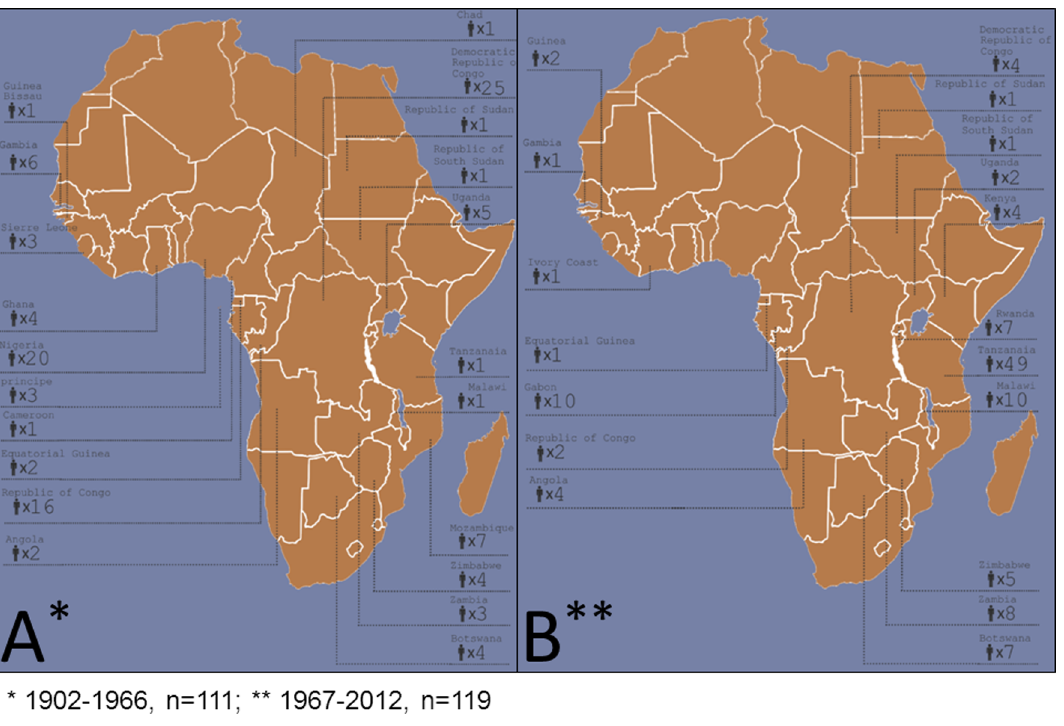
Figure 2. Geographical distribution of HAT cases among patients from non-endemic countries in the colonial (1902–1966) (A) and post-colonial (1967–2012) (B) periods.